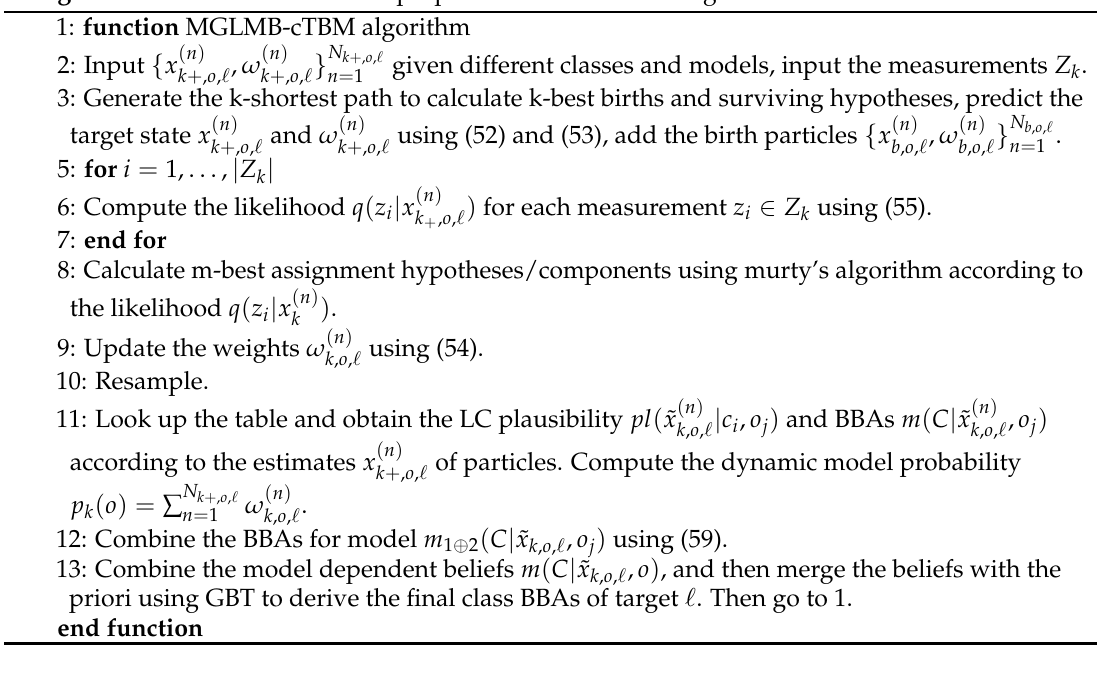
Algorithm 2: Pseudo-code of the proposed MGLMB-cTBM